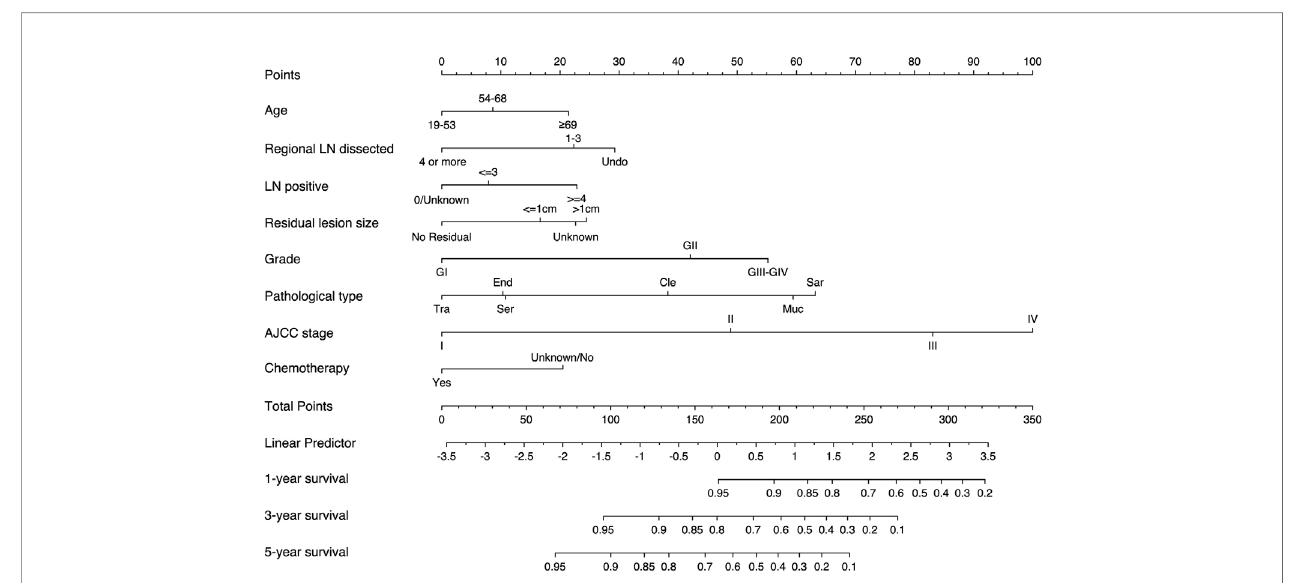
FIGURE 3 | Nomogram for predicting 1-, 3-, and 5-year CSS in adult patients who underwent primary surgery for EOC. LN, lymph node; AJCC, American Joint Commission on Cancer; CSS, cancer-speci fi c survival; EOC, epithelial ovarian cancer; Ser, serous; Muc, mucinous; End,endometrioid; Cle, clear cell adenocarcinoma; Tra, transitional cell tumor; Sar,